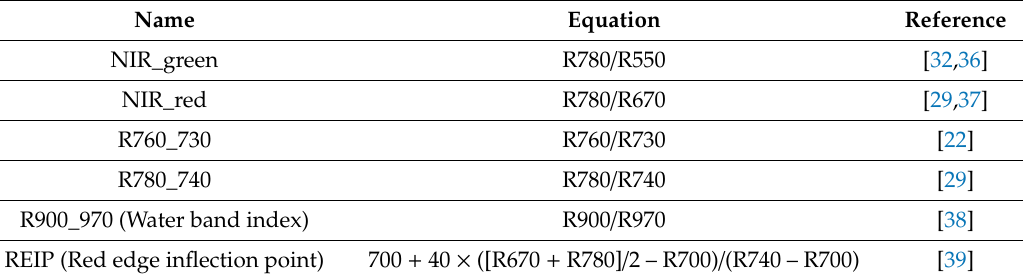
Table 3. List of vegetation indices tested in this